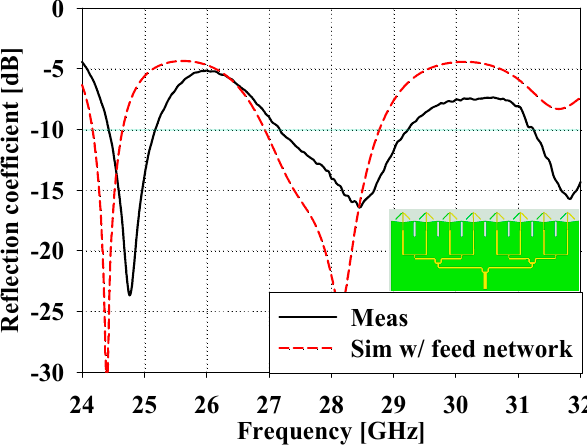
Figure 13. Measured and simulated reflection coefficient of the proposed array antenna.